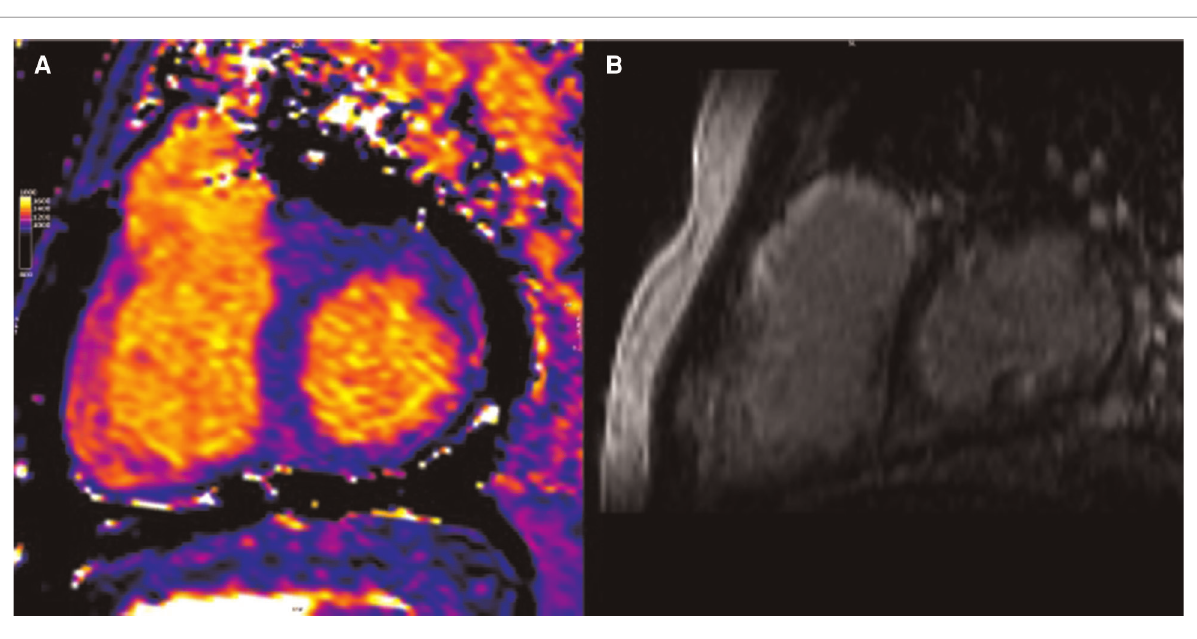
The accumulation of fi brillar collagen in the interstitial space, the so-called myocardial interstitial fi brosis, has been identi fi ed as a major cause of myocardial dysfunction. It not